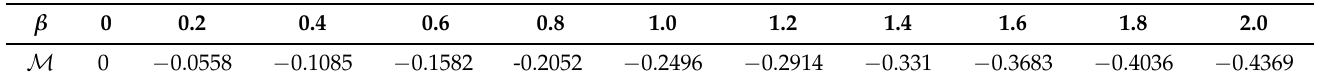
Table 4. Numerical values of M for α = 1/2 and β ∈ { 0,0.2, . . . ,1.8,2 } .